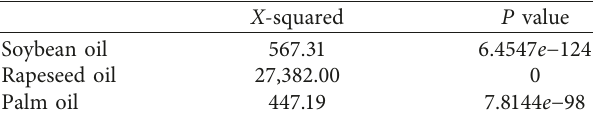
Table 2: Jarque-Bera test for daily